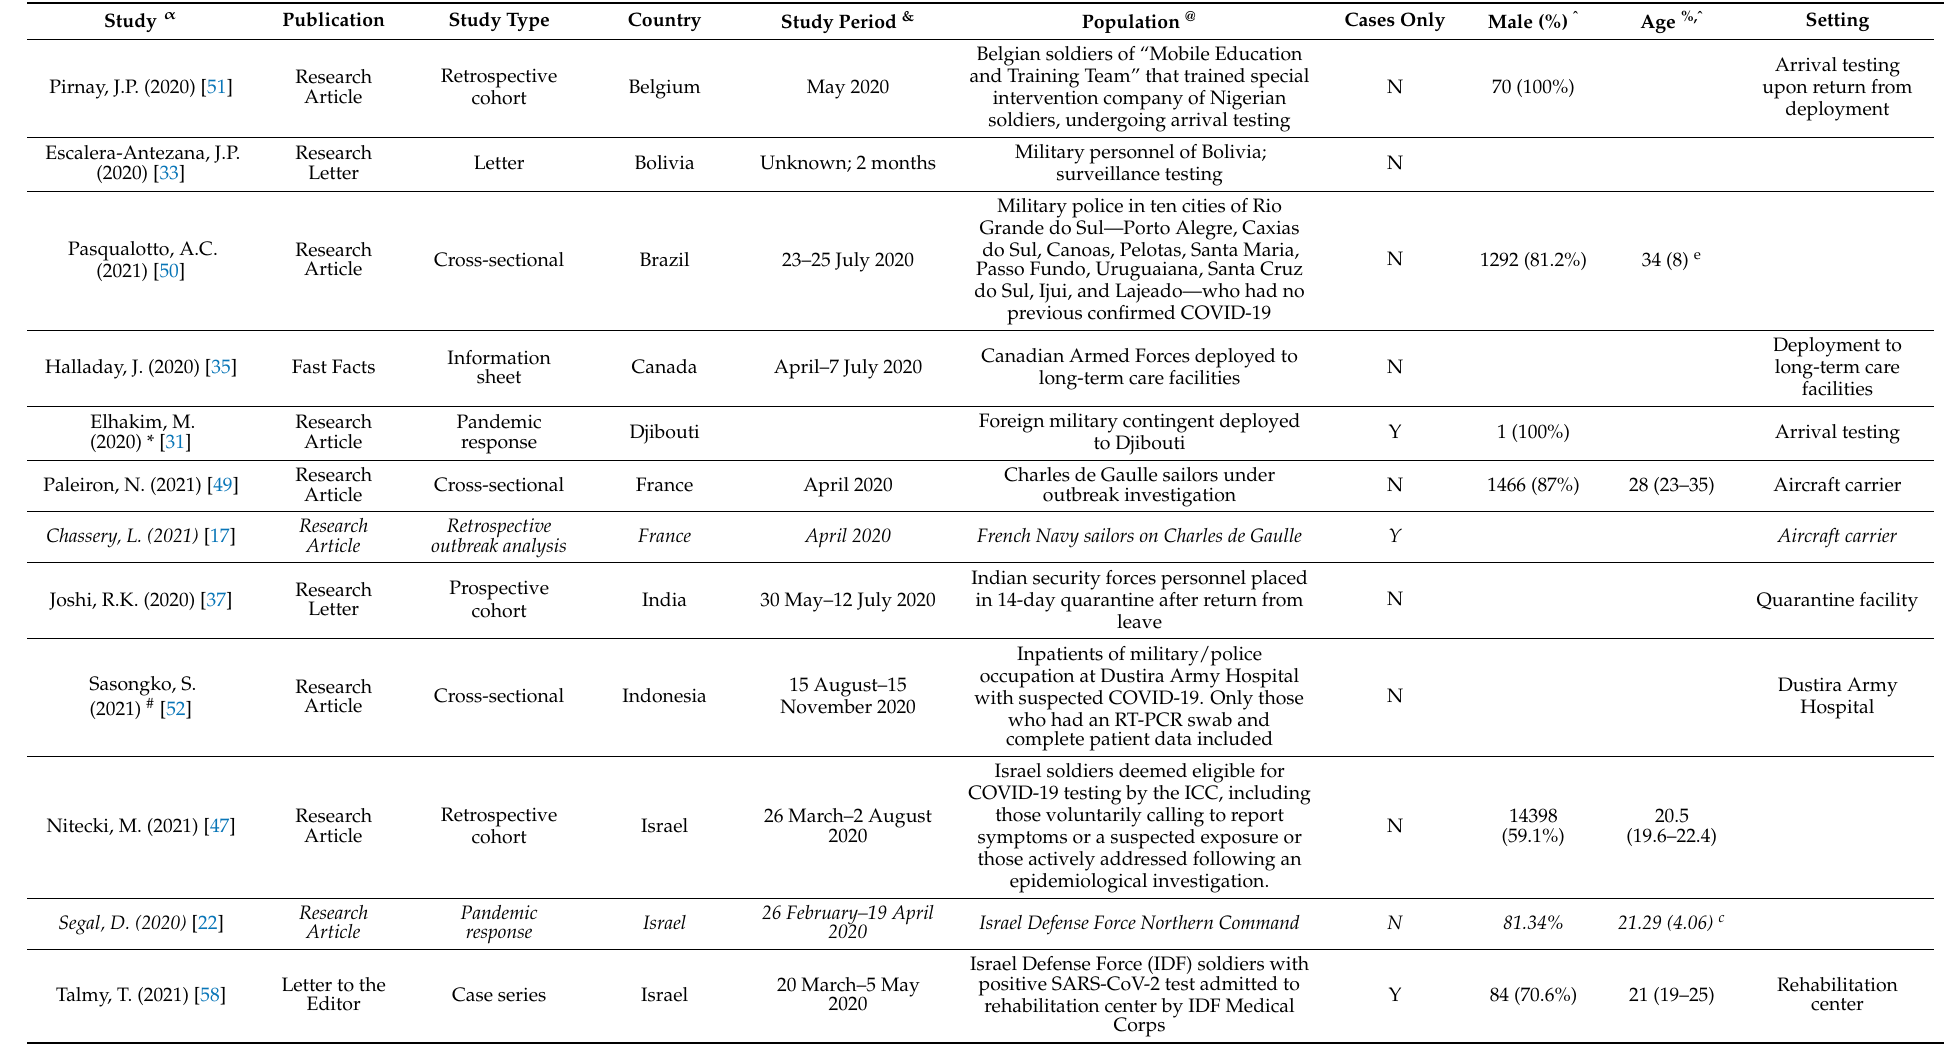
Table 1. Study details and population demographics of included